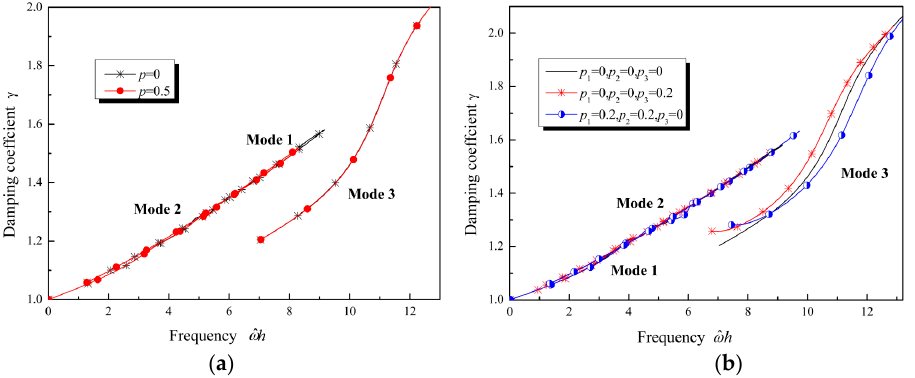
Figure 10. Damping coefficient of Lamb waves with Lamé parameters and density varying along the thickness direction: ( a ) Material parameters varying following the same exponential function; ( b ) material parameters varying following a linear function.